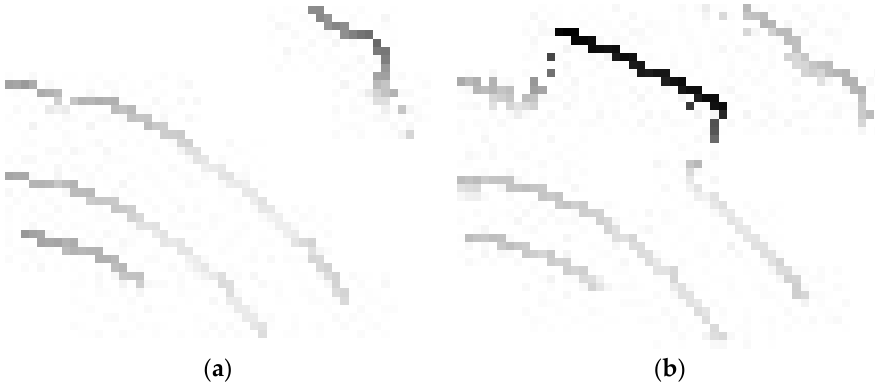
Figure 7. High range raster image. ( a ) Groove-less; ( b ) grooved.